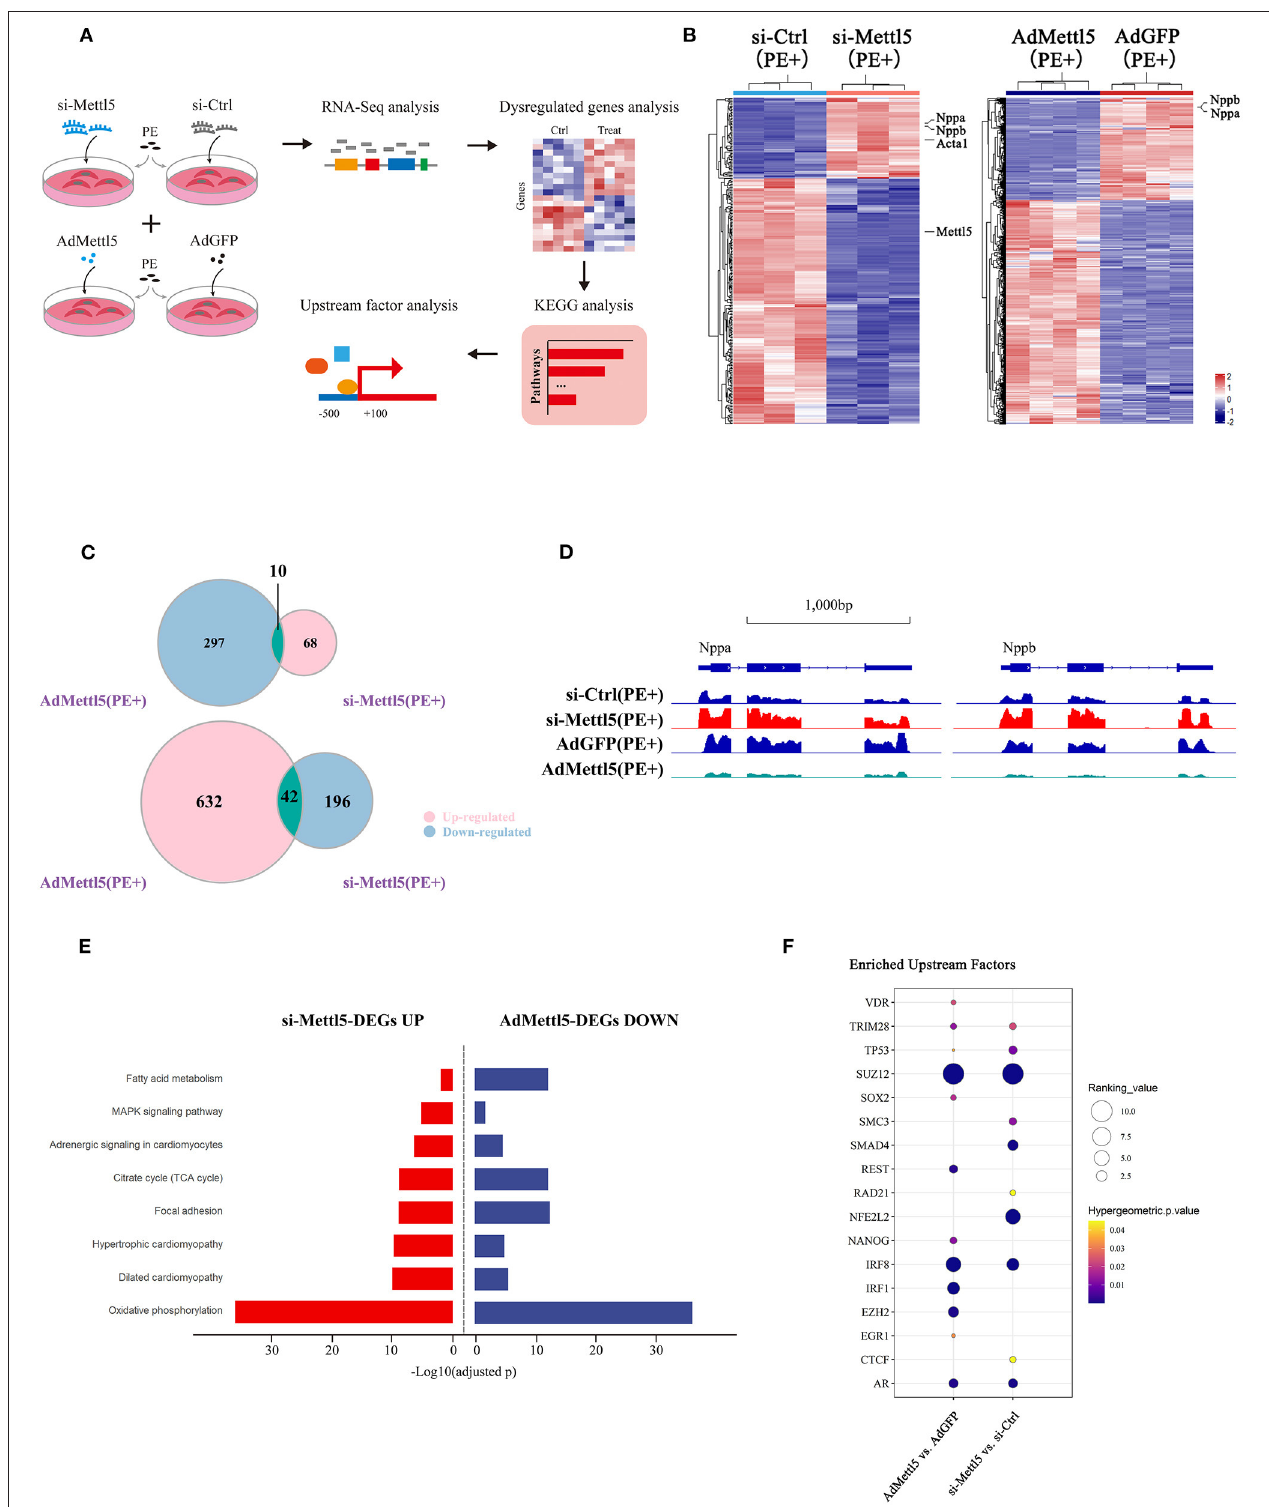
FIGURE 4 | Transcriptome analyses reveal SUZ12 as a key mediator of METTL5-regulated cardiac phenotype. (A) Schematic showing the experimental design and workflow of transcriptome analyses of siRNA and adenovirus-treated NRVMs under the stimulation of PE. (B) Hierarchical clustering of differentially expressed